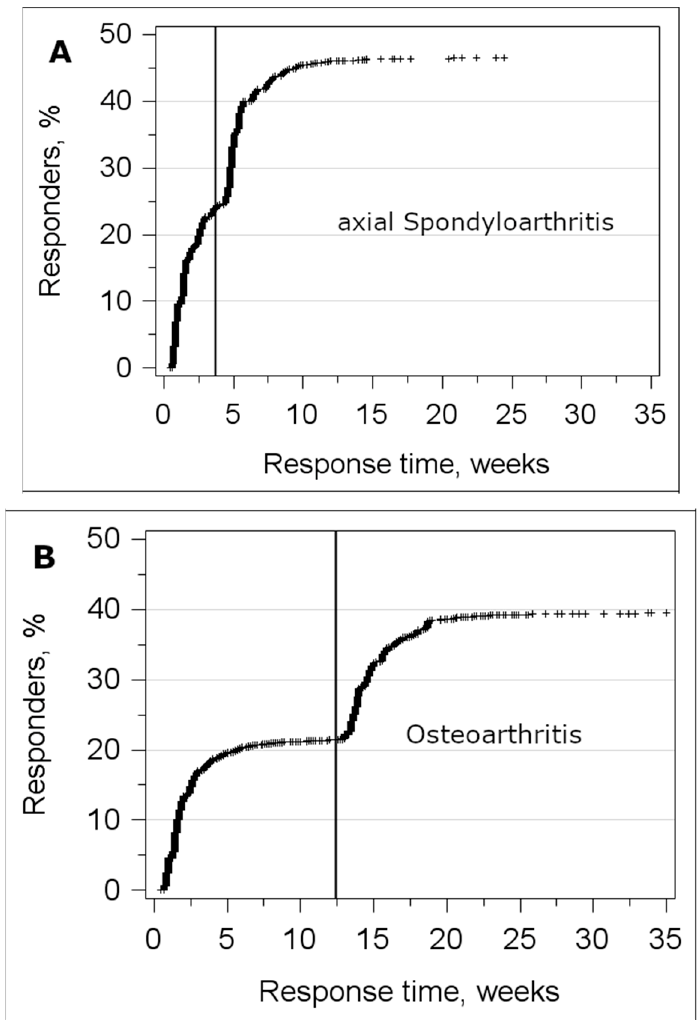
Figure 3. Title: Response by time. Legend: Proportion of responders by response time for ( A ) axial spondyloarthritis (n = 2082) and ( B ) osteoarthritis (n = 3550). The vertical lines mark the time when the reminders were sent.